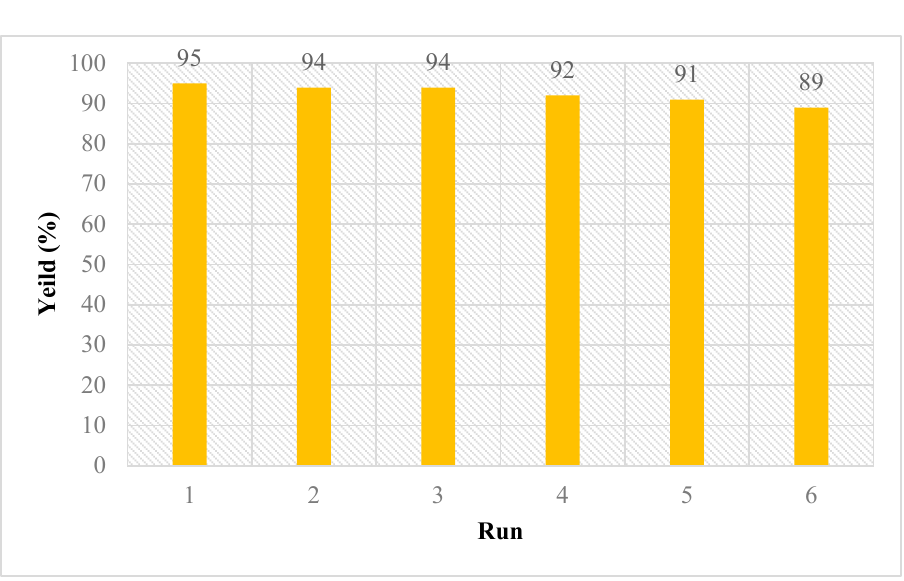
Figure 7. The results of recycling the catalyst in the synthesis of 1,4-dihydropyrano[2,3-c]pyrazole-5-carbonitrile.